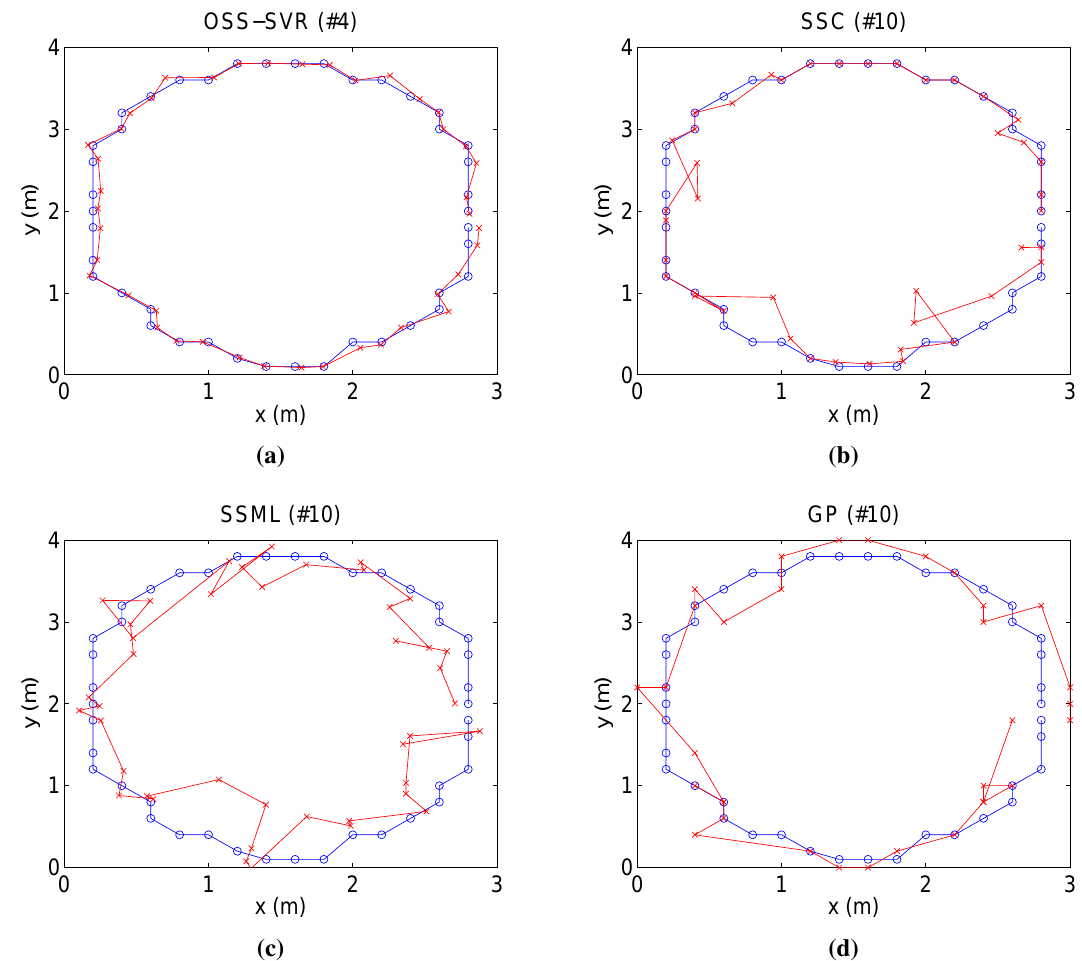
Figure 3. Localization results of a circular trajectory for four different methods. Target circles ground repeatedly, whose true trajectory is marked by the blue-circled line, and the estimated path is shown in red line. All of the figures show online tracking results where the title number of each figure indicates the number of laps the target has